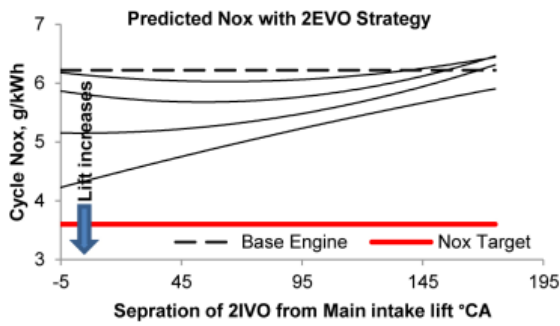
Fig. 13 Predicted NO X with 2EVO strategy [84].